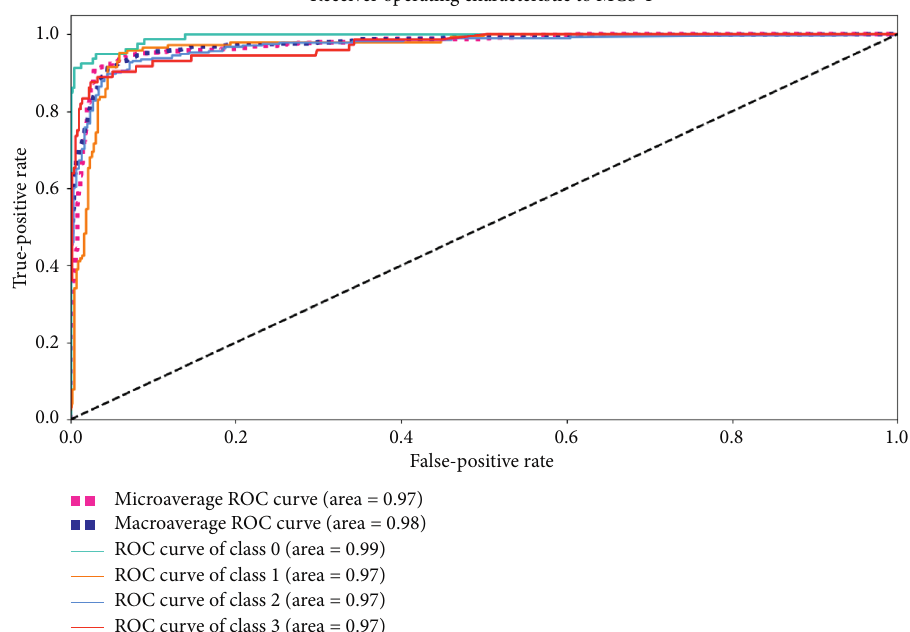
Figure 9: Area under the curve for MCS-1.